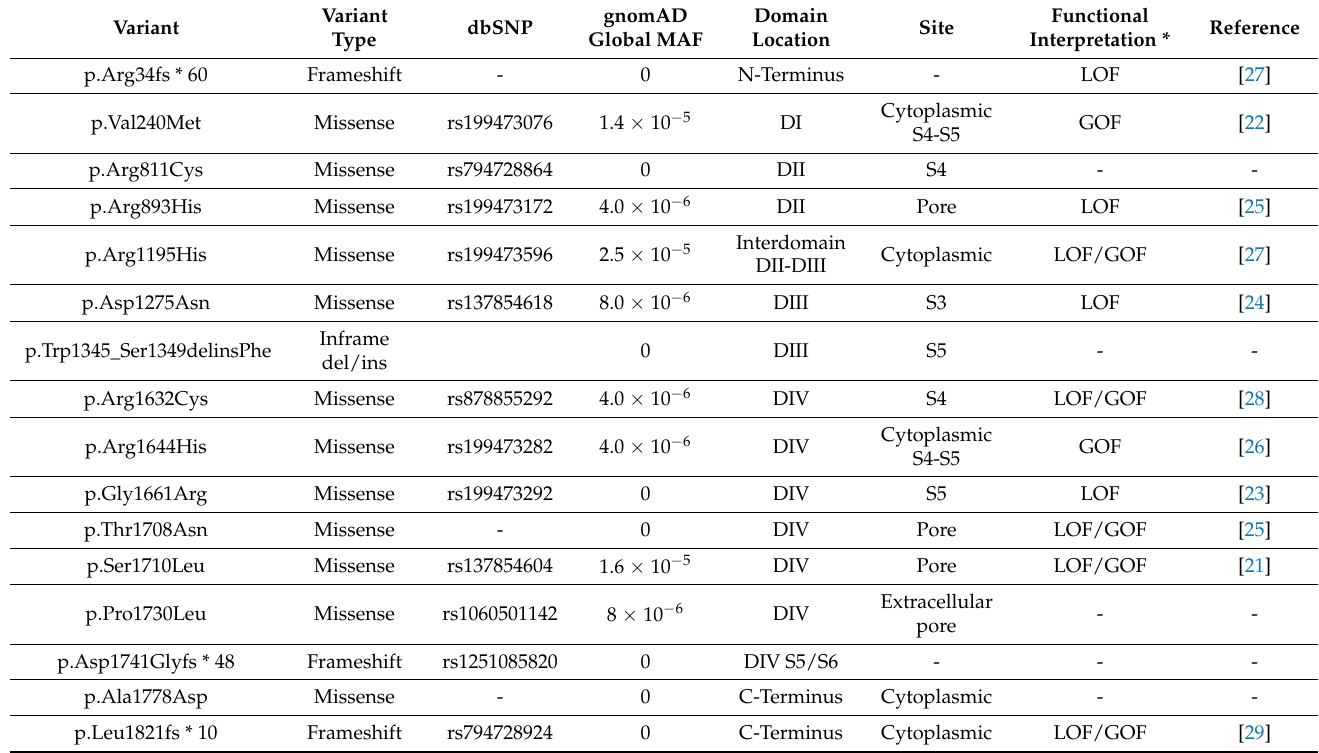
Table 1. SCN5A variants identified in children with arrhythmogenic